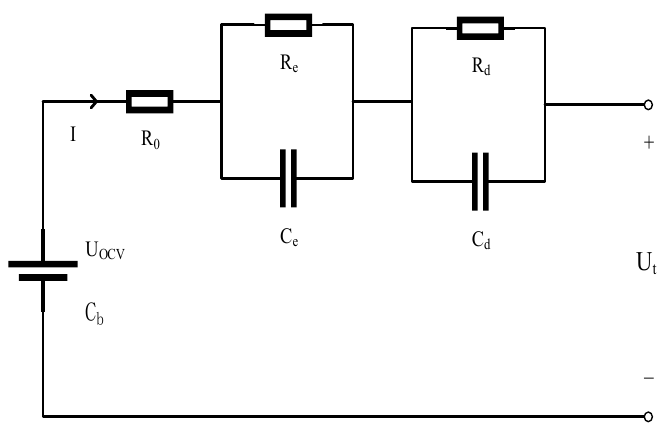
Figure 4. Battery pack model.